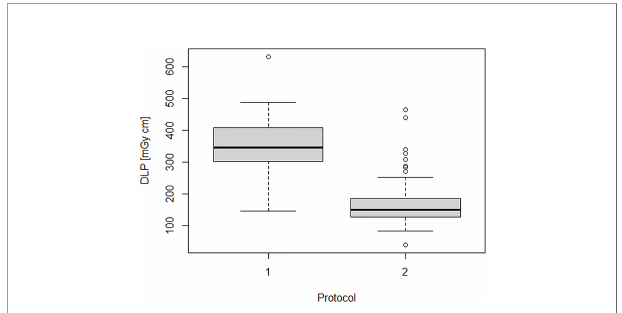
FIGURE 2 | DLP distributions for the original protocol (1) and for the optimized protocol